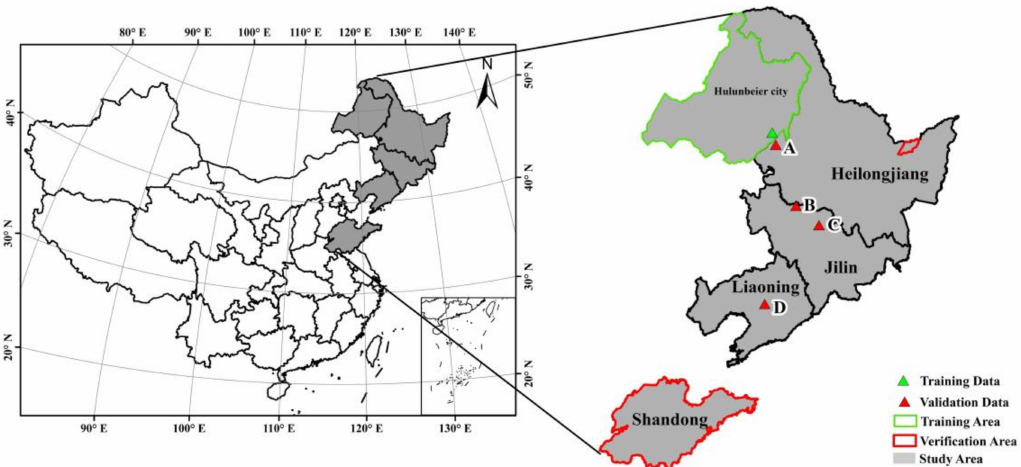
Figure 1. ( A – D ) Geographical location of the study area and distribution of training data and validation